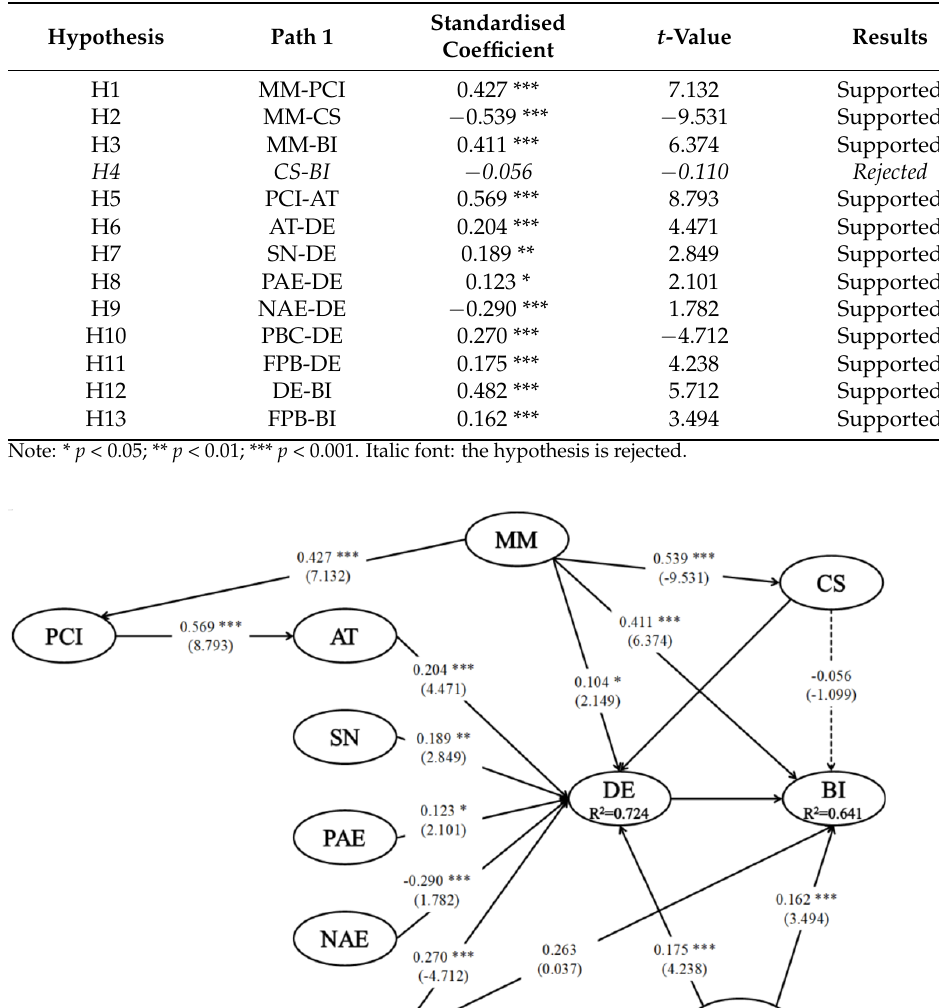
Table 6. The results of the structural model.